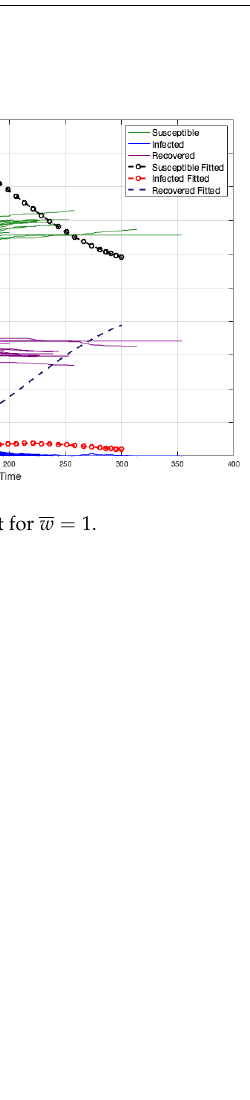
Figure 20. Curves fitted without considering S = w · m